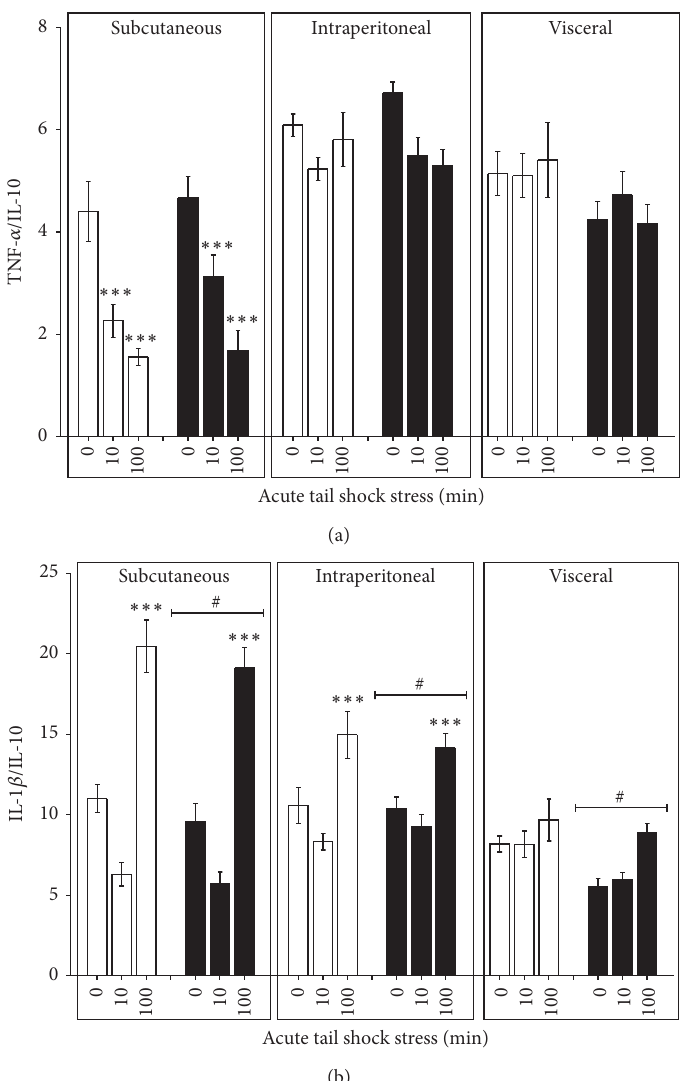
Figure 3: Effect of a 24 h fast on the inflammatory status of WAT following 10 or 100 acute inescapable tail shocks. Fed (FED ◻ ) or fasted (FASTED ◼ ) rats were exposed to 0 (control condition), 10, or 100 acute, inescapable tail shocks (IS) and immediately sacrificed and subcutaneous, intraperitoneal, and visceral WAT were collected. Shown is the ratio of the mean (+SEM) concentration of (a) TNF- 𝛼 /IL-10 and (b) IL-1 𝛽 /IL-10, ∗∗∗ 𝑝 < 0.0001 (0IS versus 10 or 100IS within WAT compartment); # 𝑝 < 0.05 (main effect of FED versus FASTED within WAT